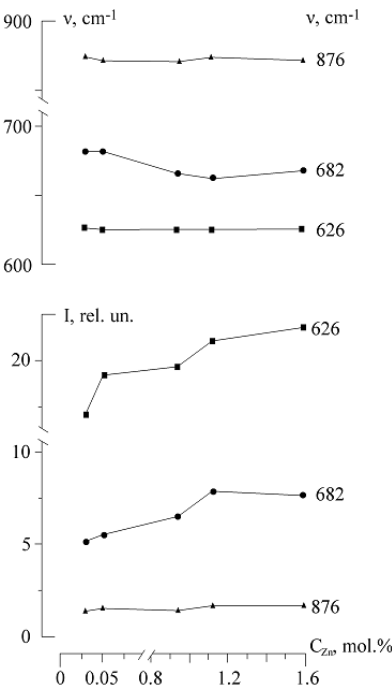
Figure 25. Dependence of frequencies ( ν , cm − 1 ), widths (S, cm − 1 ) and intencities (I, rel. un.) of 626 (А 1 (ТО)) , 682, 876 cm − 1 bands in Raman spectra of LiNbO 3 :Zn crystals on the Zn 2+ concentration. The figure is reproduced with the permission of Pleiades Publishing, Ltd. from the paper Opt. Spectrosc. 2014, V. 116, P. 281 – 290. doi: 10.1134/S0030400X14010202.